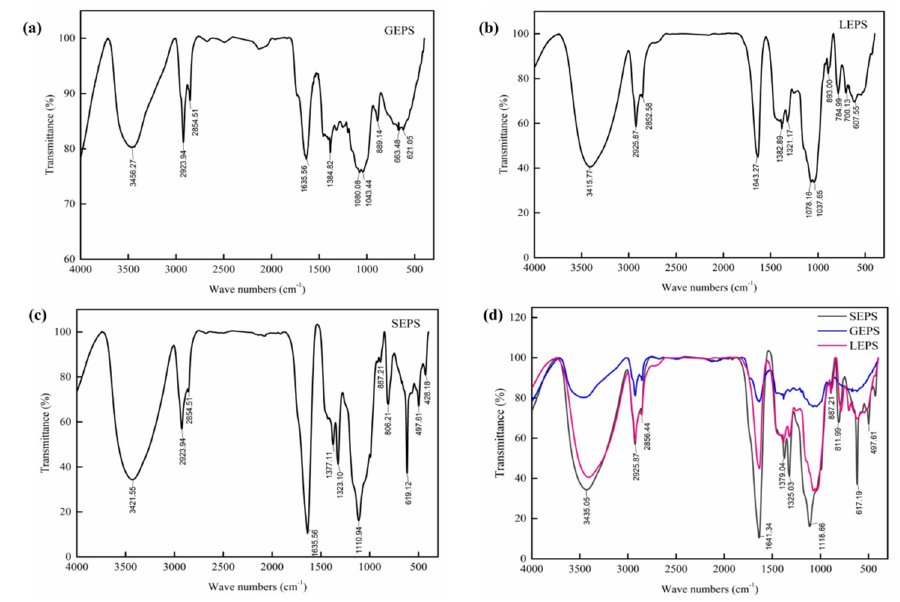
Figure 4. The FT-IR spectrum of ( a ) GEPS (glucose was used as the carbon source), ( b ) LEPS (lactose was used as the carbon source), ( c ) SEPS (sucrose was used as the carbon source) and ( d ) their comparison.